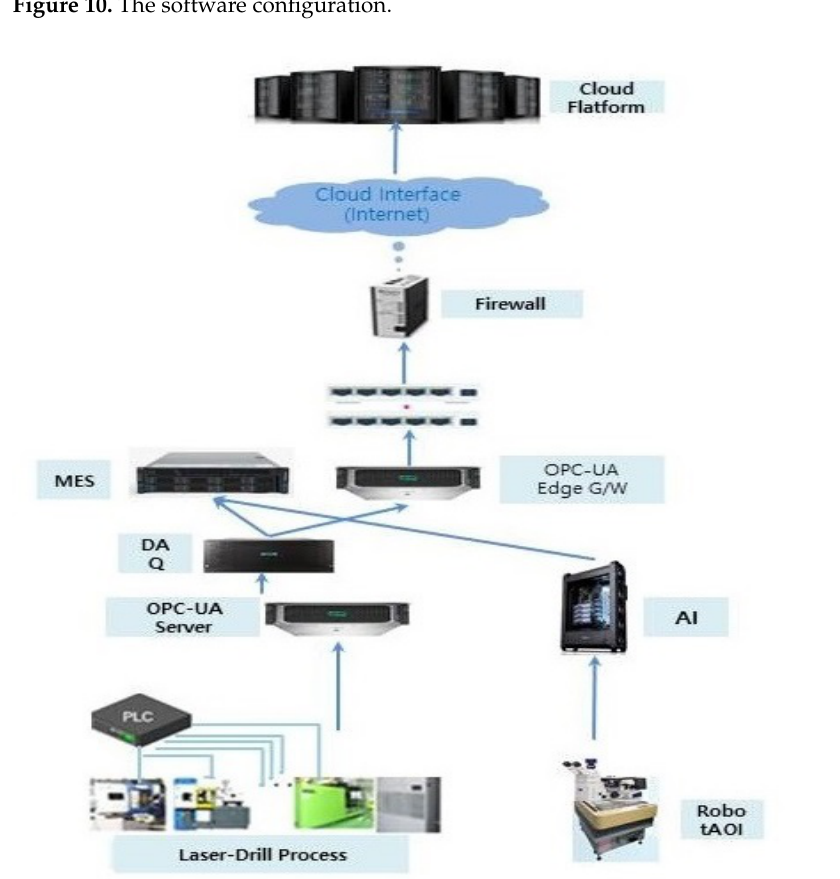
Figure 11. The configuration of the data gathering